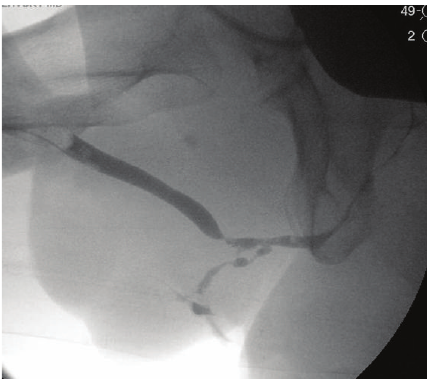
Figure 1: Preoperative retrograde urethrogram and attempted voiding